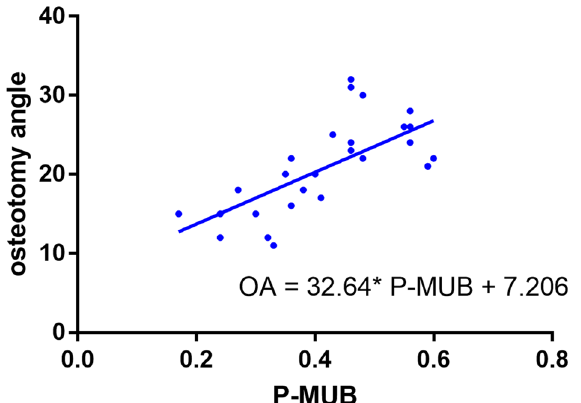
Figure 4. The linear regression equation. OA = 32.64* P-MUB + 7.206, R 2 = 0.459, P < 0.0001.